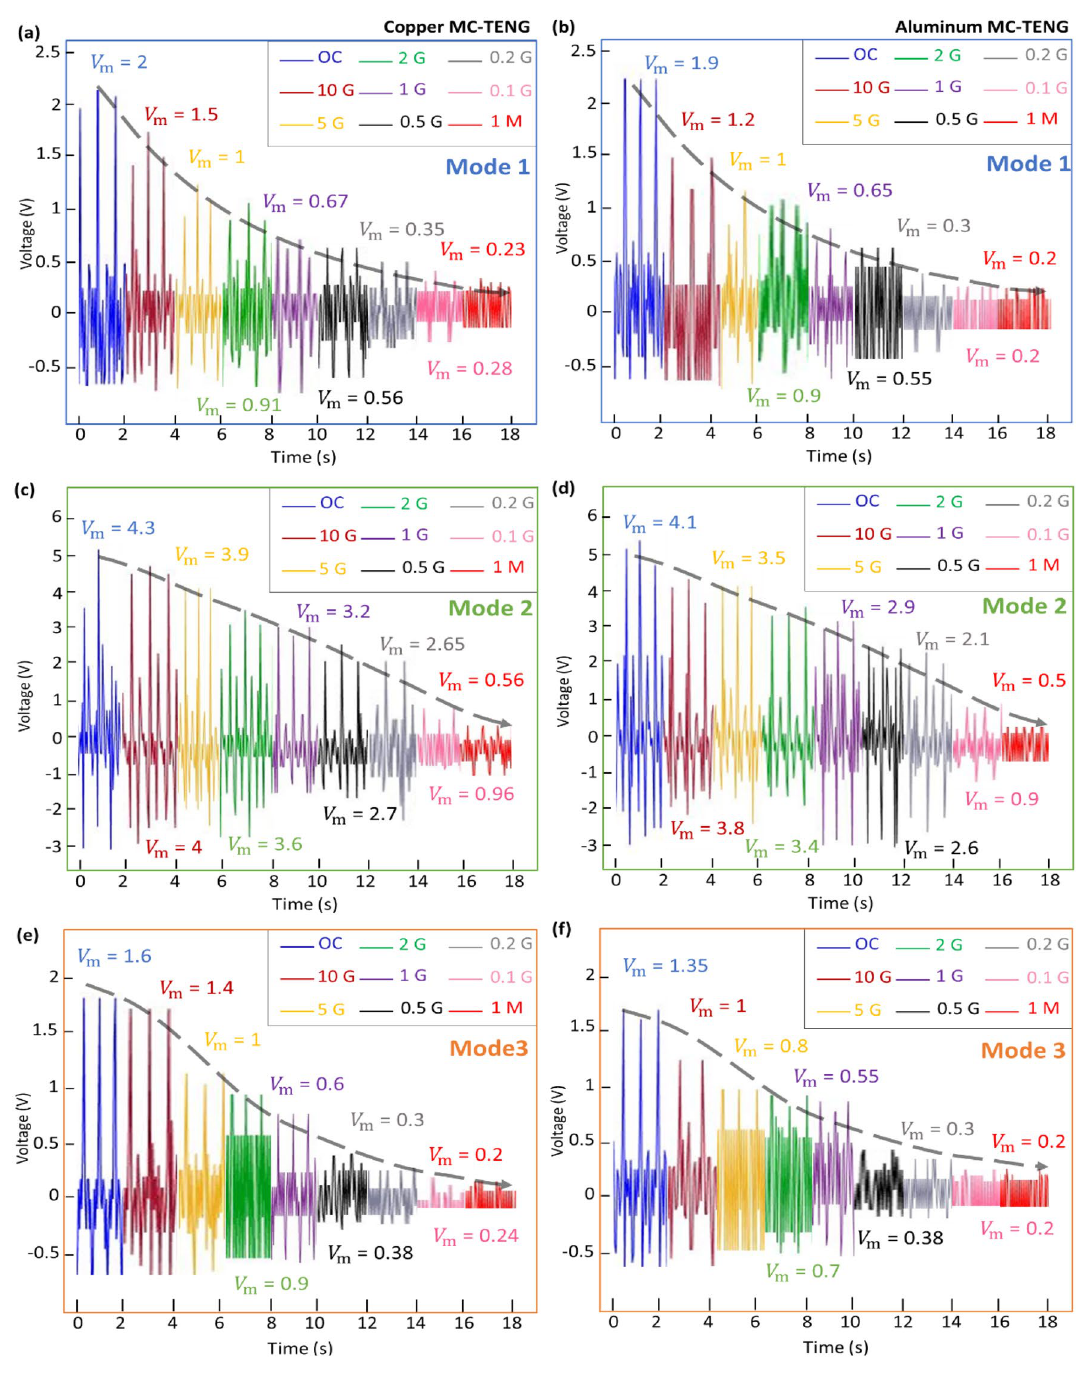
Figure 3. Energy harvesting performance of the copper and aluminum MC-TENG in the three modes. Voltage distribution trends of the ( a ) copper and ( b ) aluminum MC-TENG in mode 1, ( c ) copper and ( d ) aluminum MC-TENG in mode 2, and ( e ) copper and ( f ) aluminum MC-TENG in mode 3 (all the capsulate TENG are designed with 4 end magnets on each end, the loading time is fixed as 2 s, and the electrical resistance in the closed-circuit is varied from 1 MΩ to 10